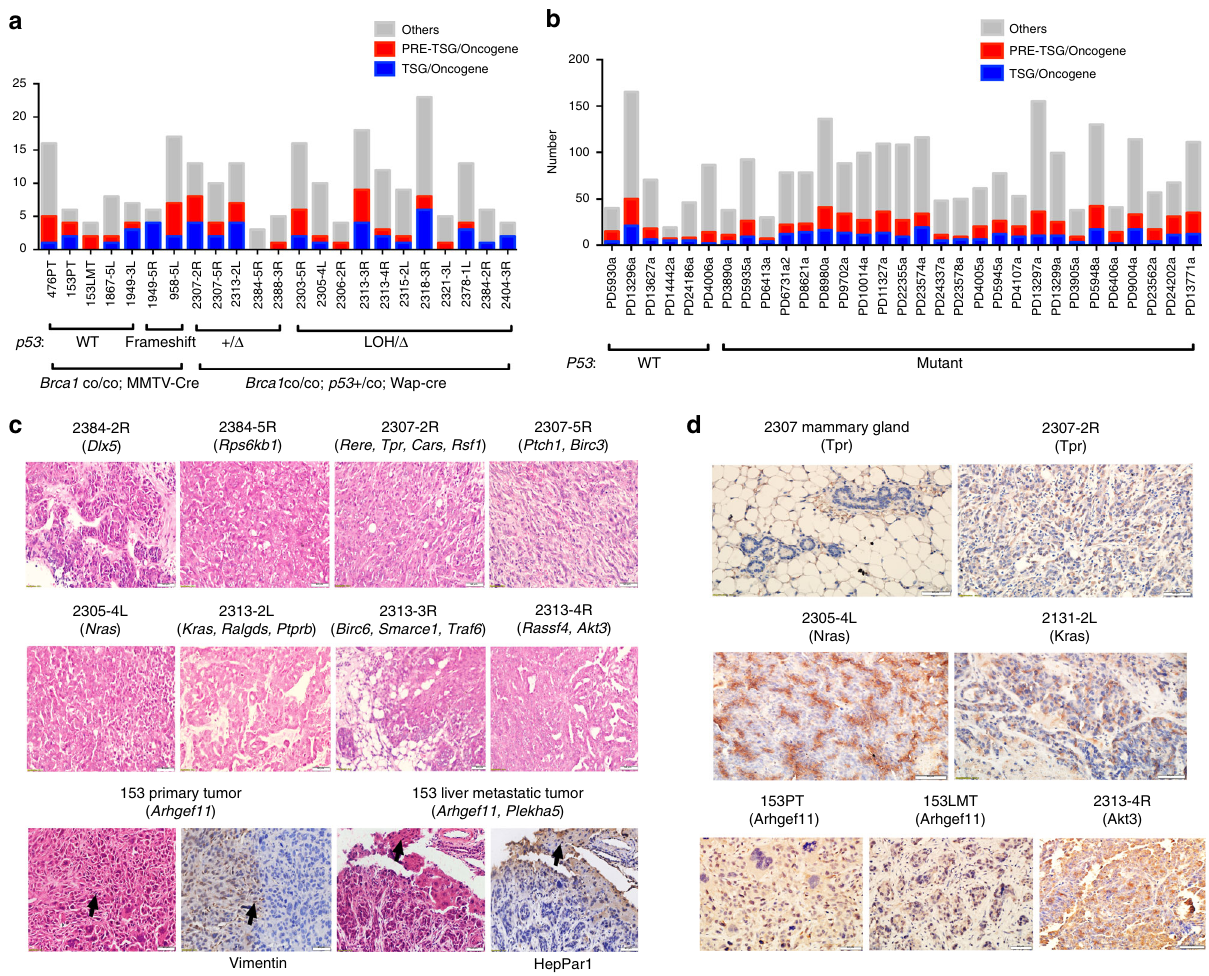
Fig. 2 Identi fi cation of drivers showing high inter-tumor heterogeneity in Brca1 -de fi cient tumors. a Bar plot showing the number of TSGs/oncogenes and predicted TSGs/oncogenes mutated in each Brca1 -de fi cient breast tumor of Brca1 MKO mice. b Bar plot showing the number of TSGs/oncogenes and predicted TSGs/oncogenes mutated in each breast tumor of patients with BRCA1 germline mutation from the WSI dataset. c Histology and IHC staining showing the morphology in tumors carrying different potential driver mutations (indicated in the brackets). One representative sections were shown for each tumor. Scale bars, 50 μ m. The bottom panel shows H&E and IHC staining in adjacent sections of 153PT and 153LMT. The fi rst arrow of the bottom panel indicates aggressive mesenchymal tumor cells; the second arrow indicates aggressive mesenchymal tumor cells positive for EMT marker Vimentin; the third arrow indicates hepatocyte; the fourth arrow indicates hepatocyte positive for hepatocyte-speci fi c marker HepPar1. d IHC staining of tumors using their corresponding potential driver oncogenes called from the WES data. All antibodies used are shown in the brackets. One representative section was shown for each tumor. Scale bars, 50 μ